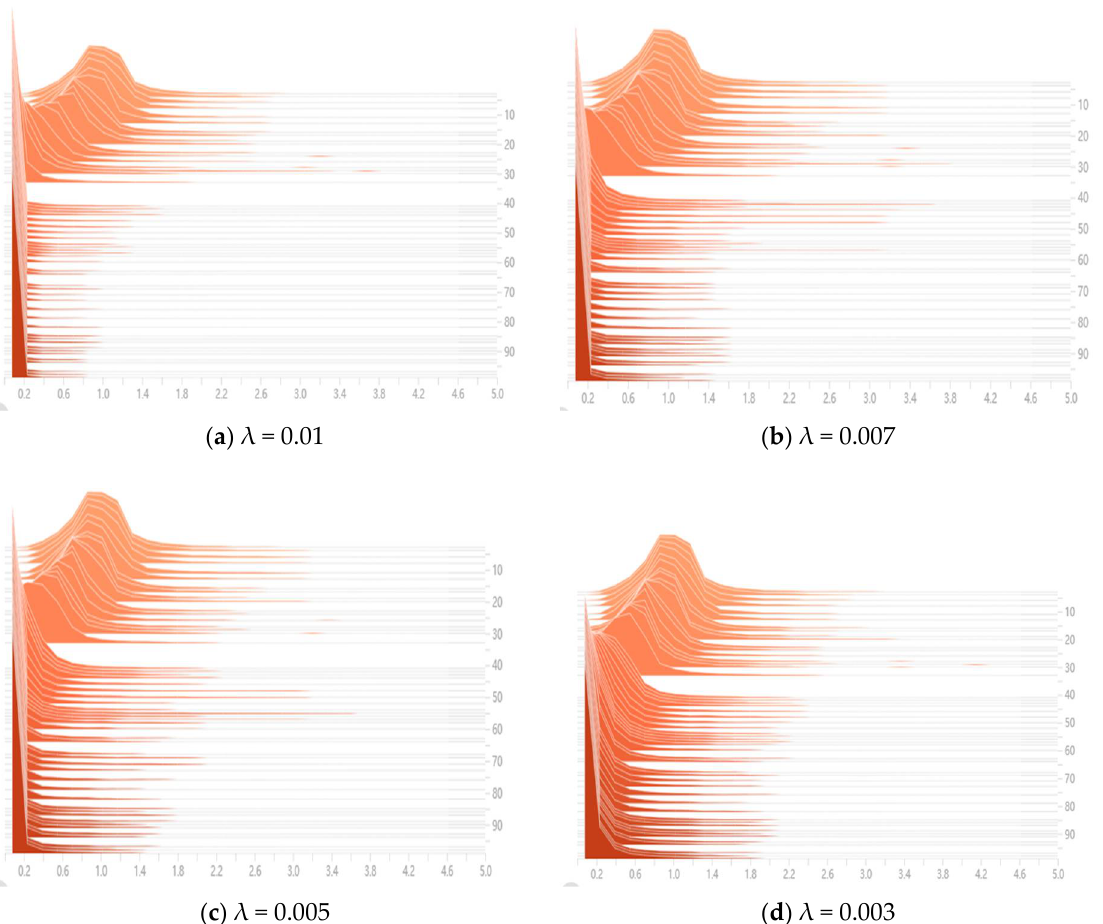
Figure 9. Distribution of sparse training scaling factor. ( a ) is the distribution of the BN layer scaling factor when the sparse rate is 0.01; ( b ) is the distribution of the BN layer scaling factor when the sparse rate is 0.007; ( c ) is the distribution of the BN layer scaling factor when the sparse rate is 0.005; ( d ) is the distribution of the BN layer scaling factor when the sparse rate is 0.003.